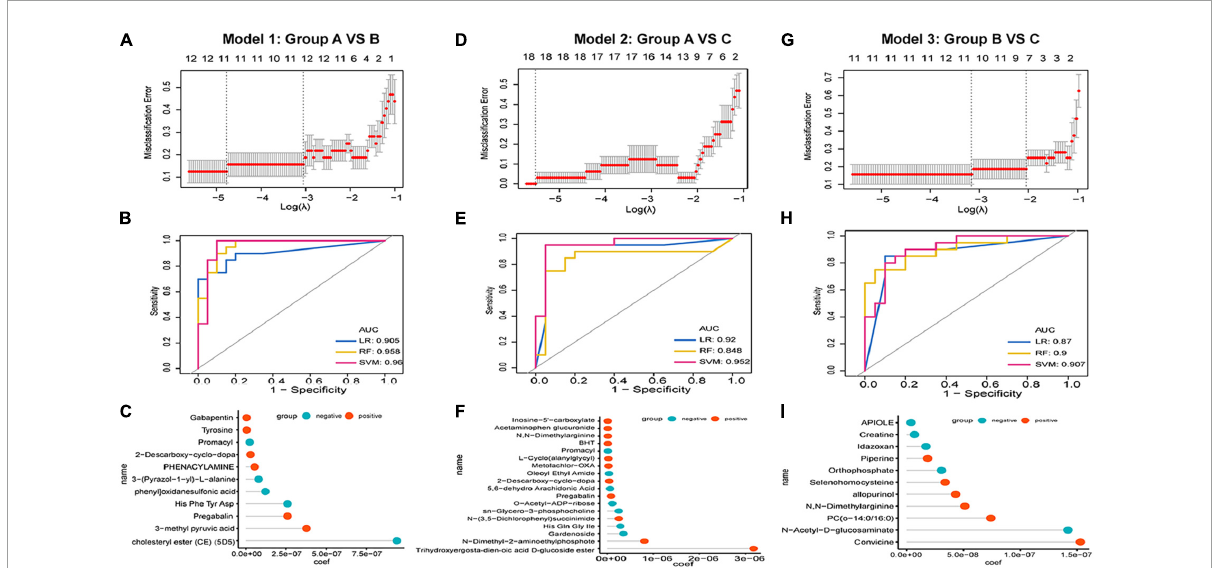
FIGURE4 Development of predictive models in HZ and PHN based on metabolic patterns and machine learning. (A–C) Development of predictive model 1 group A vs. B: (A) LASSO regression, (B) the receiver operating characteristic curves of three classifiers, (C) correlation coefficient of specific metabolite in the model; (D–F) development of predictive model 1 Model 2 group A vs. C: (D) LASSO regression, (E) the receiver operating characteristic curves of three classifiers, (F) correlation coefficient of specific metabolite in the model; (G–I) development of predictive model 1 Model 2 group A vs. C: (G) LASSO regression, (H) the receiver operating characteristic curves of three classifiers, (I) correlation coefficient of specific metabolite in the